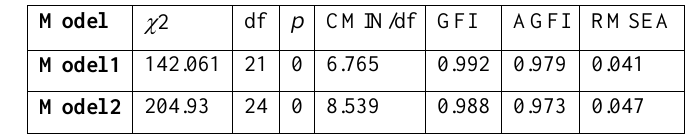
Table 4 Structural equation model fitting test of undergraduates’ life stressor-induced depressive symptoms and light business